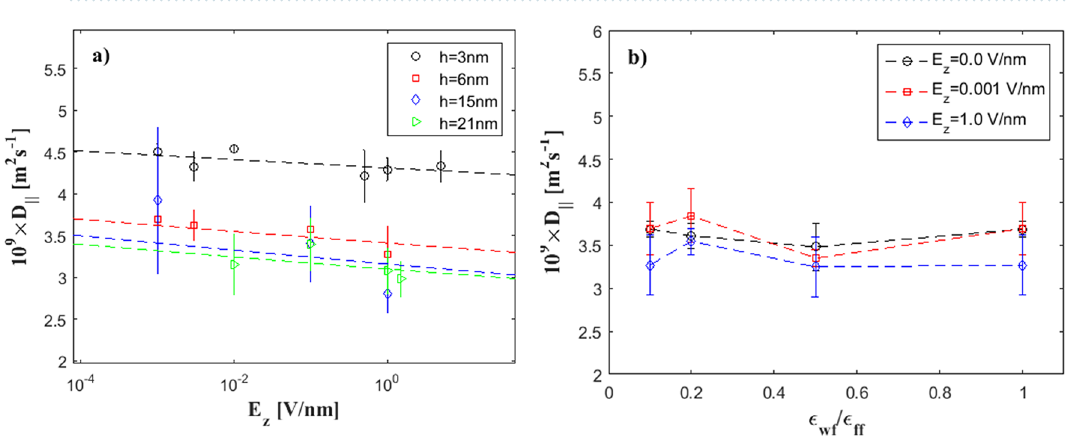
Figure 5. Calculated mean square displacement of fluid particles. E z = 0.1 V/nm, ε wf /ε ff = 0.1 . ( a ) h = 15 nm, ( b ) h = 21 nm.